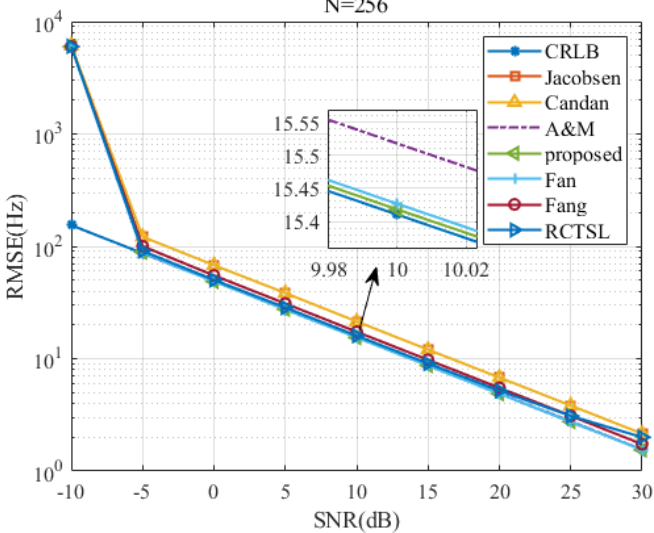
Figure 9. RMSE comparison among frequency estimates versus SNR at N = 256 and δ = 0.2.